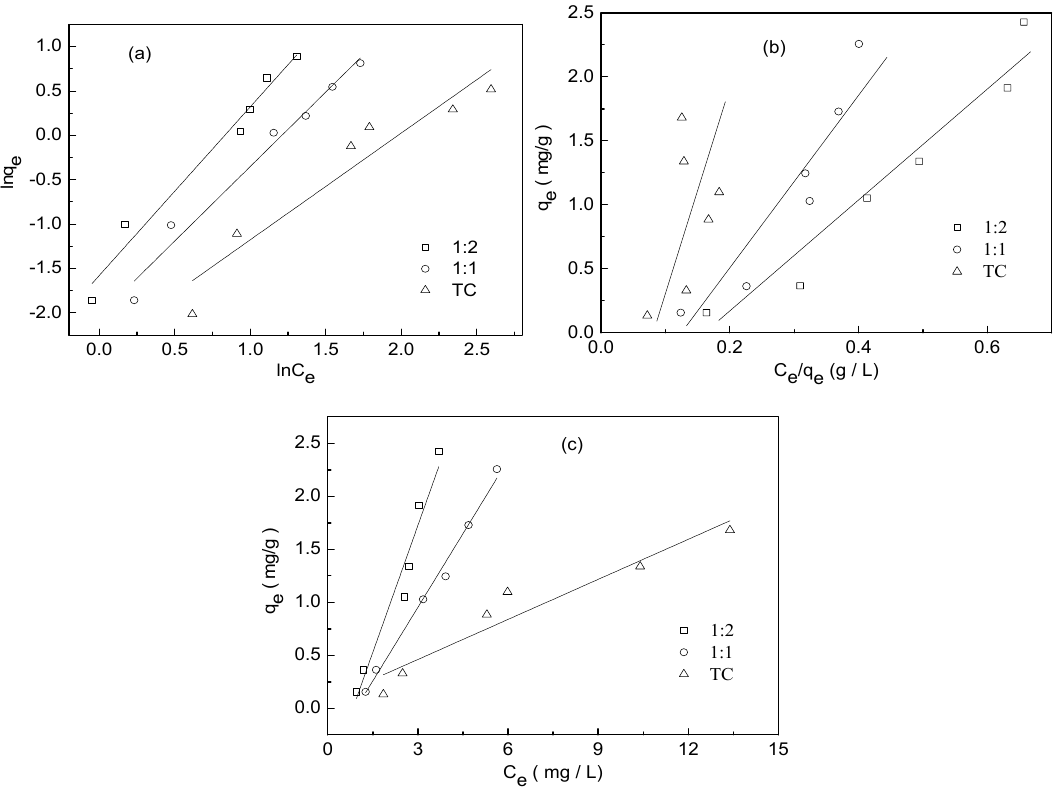
Figure 7. Three isotherm model plots for adsorption of TC in different complexation: ( a ) Freundlich, ( b )